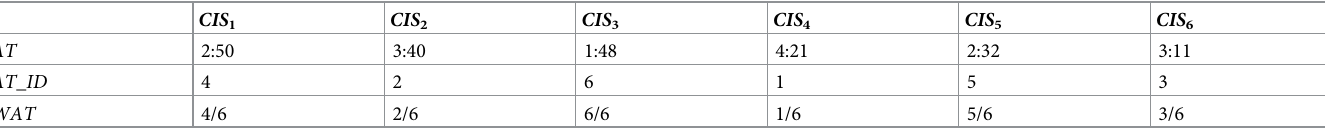
Table 2. Ranking of the AT.